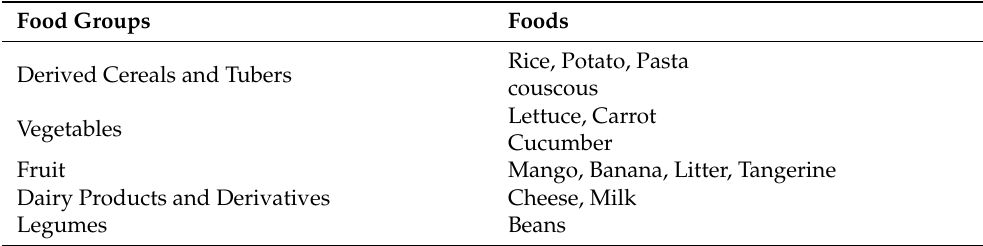
Table 4. Food preferences in Portugal.